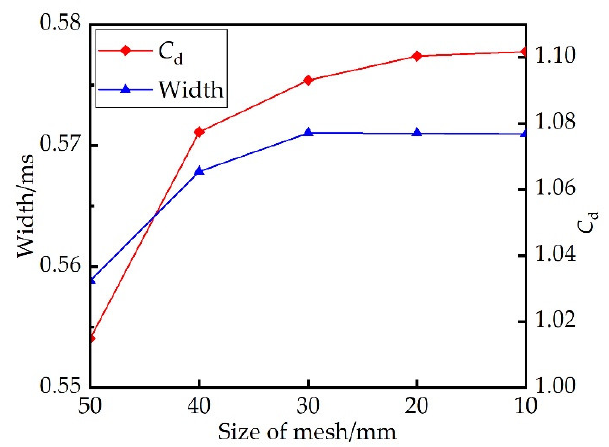
Figure 9. Peak and peak pulse width of mesh with different size.